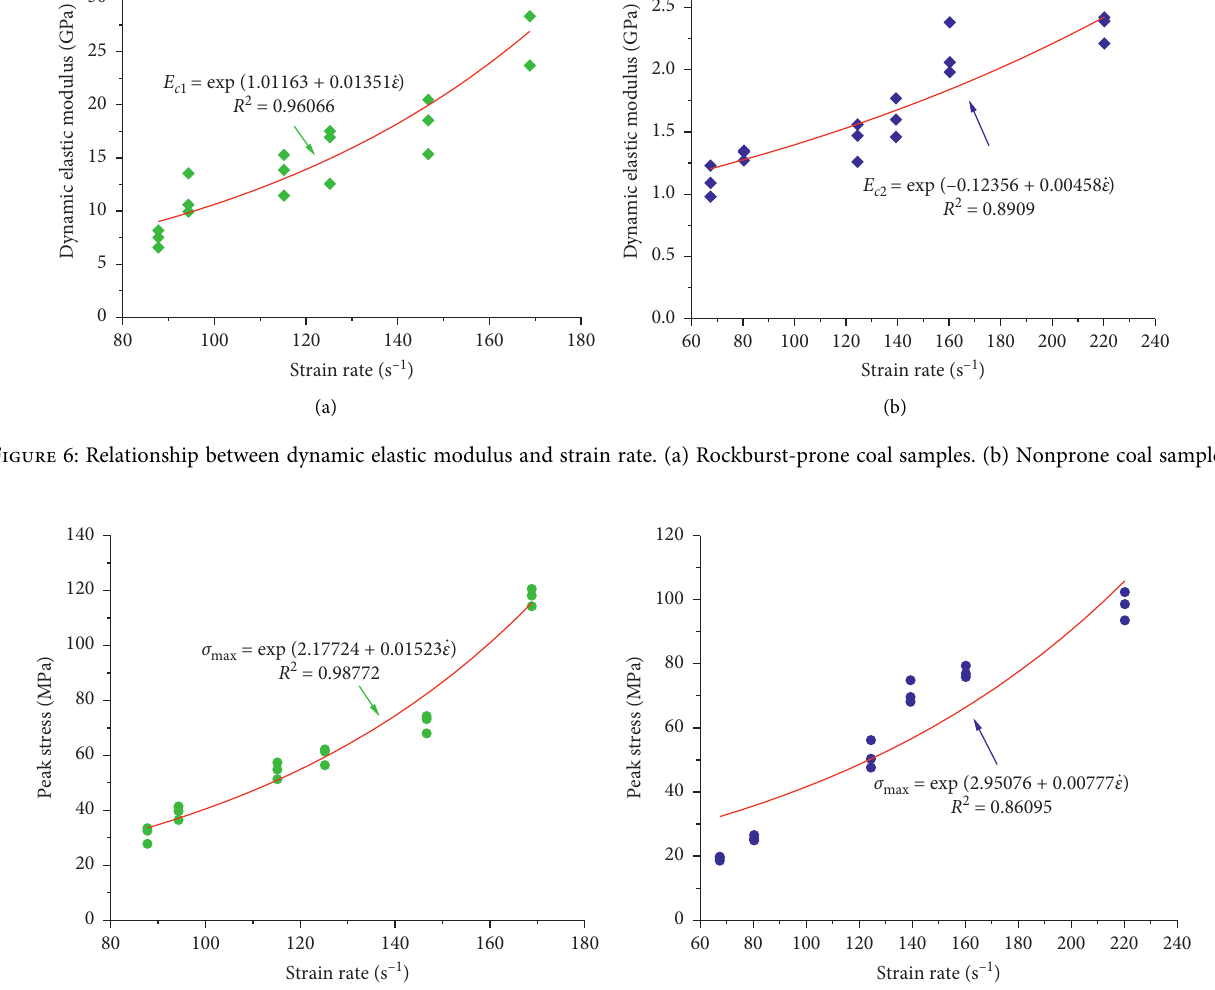
Figure 7: Relation between peak stress and strain rate. (a) Rockburst-prone coal samples. (b) Nonprone coal